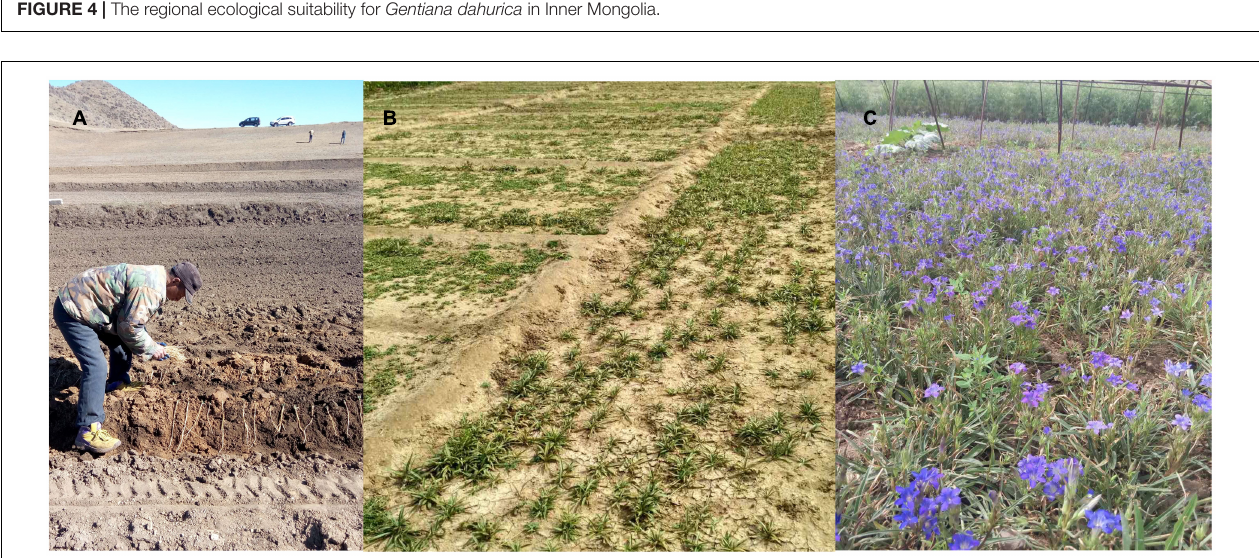
FIGURE 4 | The regional ecological suitability for Gentiana dahurica in Inner Mongolia.